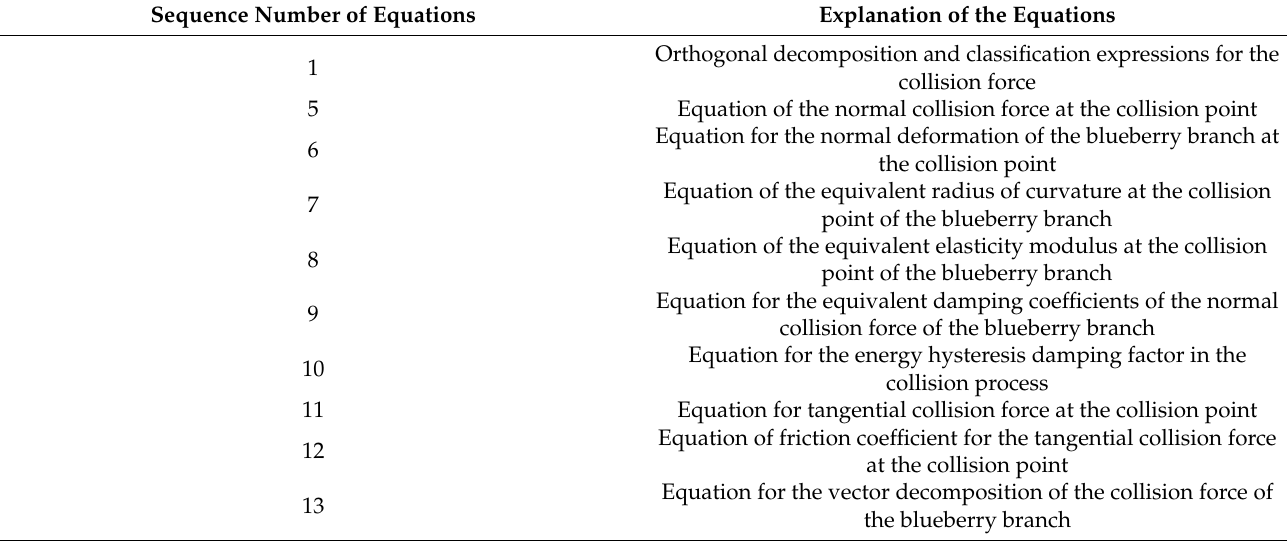
Table 1. Theoretical equations related to blueberry harvesting